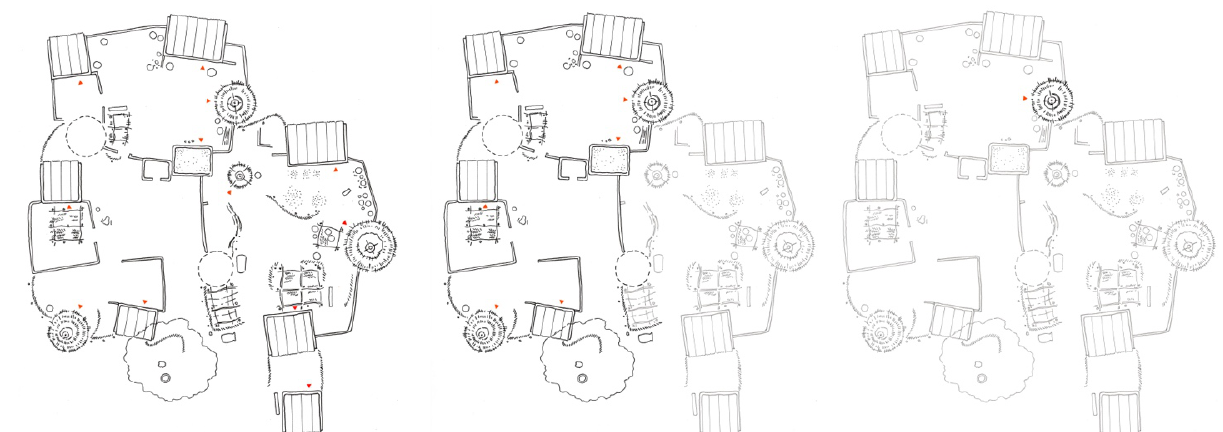
Figure 6. Levels of dwelling in